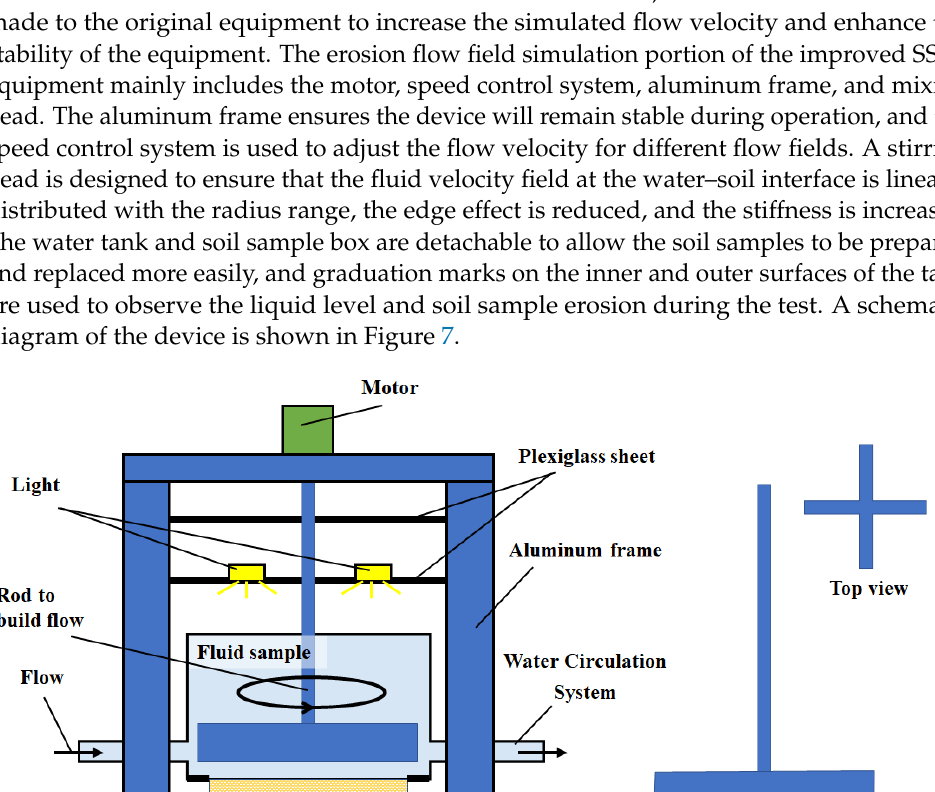
( c ) Figure 8. Photographs of simplified scour resistance tests. ( a ) Top view of specimen ( b ) Side view of specimen ( c ) Activation of erosion simulator. 4. Results and Discussion 4.1. Unconfined Compression Test Results Figure 9 presents images of typical damaged specimens from the unconfined com- pression tests. When the UCS is below 200 kPa, the damage presents in the form of a large main crack. When the UCS of the specimen is reached, a large main crack forms in the specimen, with a crack angle that is usually between 45° and 60°. When the UCS is above 200 kPa, a damage cone with an angle of approximately 45° typically forms at the top of the specimen; as the loading continues, an obvious crack forms under the action of the damage cone once the specimen reaches its limit.